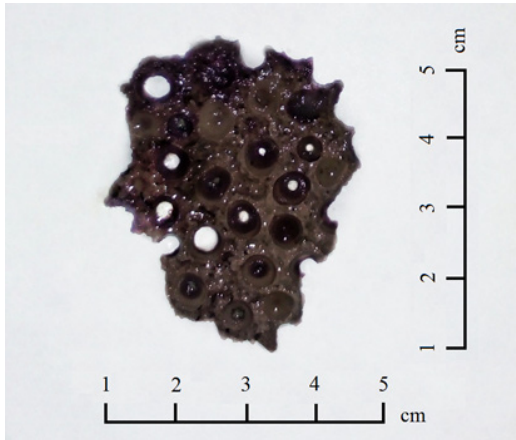
Figure 11. The sample of altered ilmenite after the leaching process in the presence of sodium fluoride.